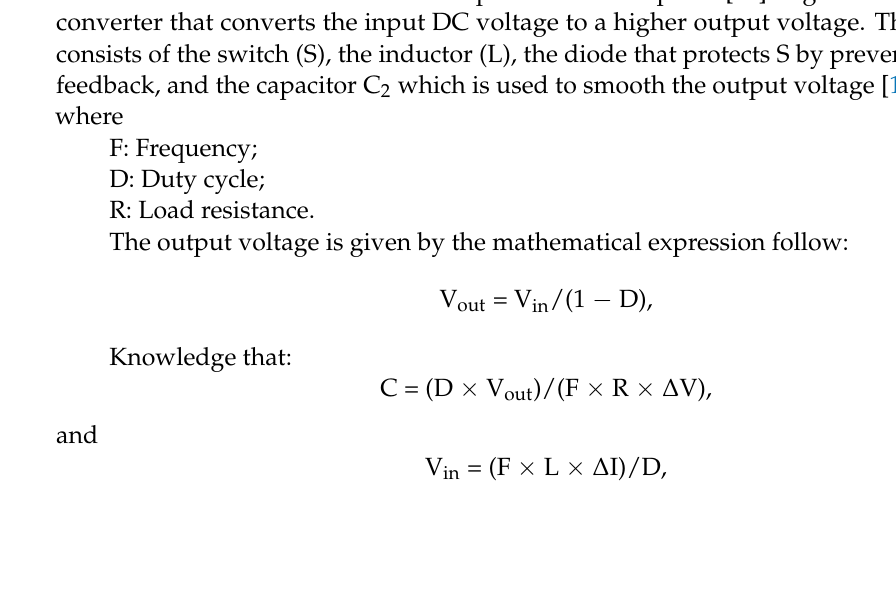
Table 1. Electrical characteristics of PV panel Hyundai Heavy Industries HiS-M280MI .